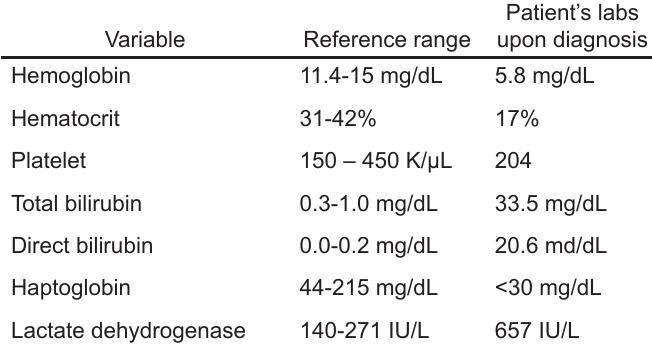
mg, milligram; dL, deciliter; µL, microliter; K, thousand; IU, international unit; L,